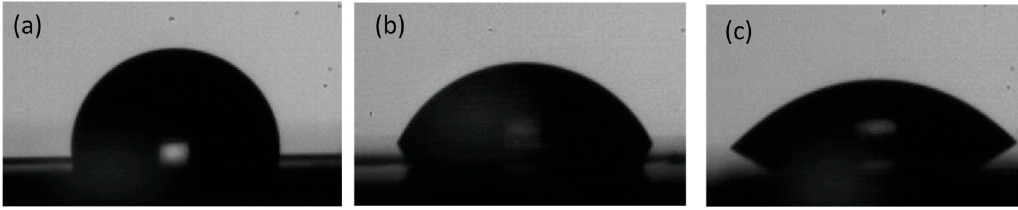
Figure 2. WCA measured on pristine PET ( a ), oxygen plasma activated-PET ( b ) and 1018K6-functionalized PET ( c ). The measurements were performed on five samples in duplicate.